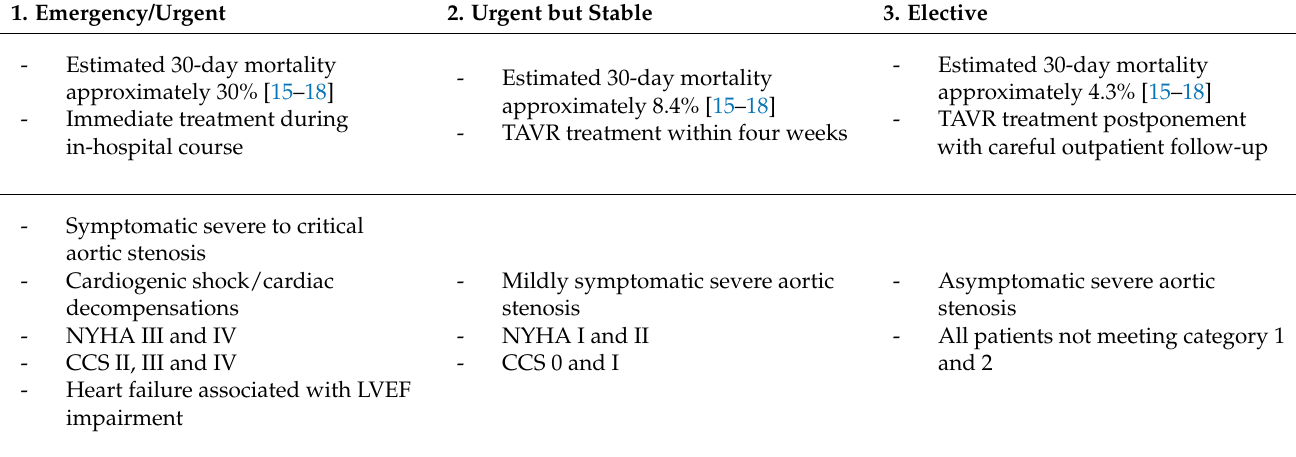
Table 1. Allocation